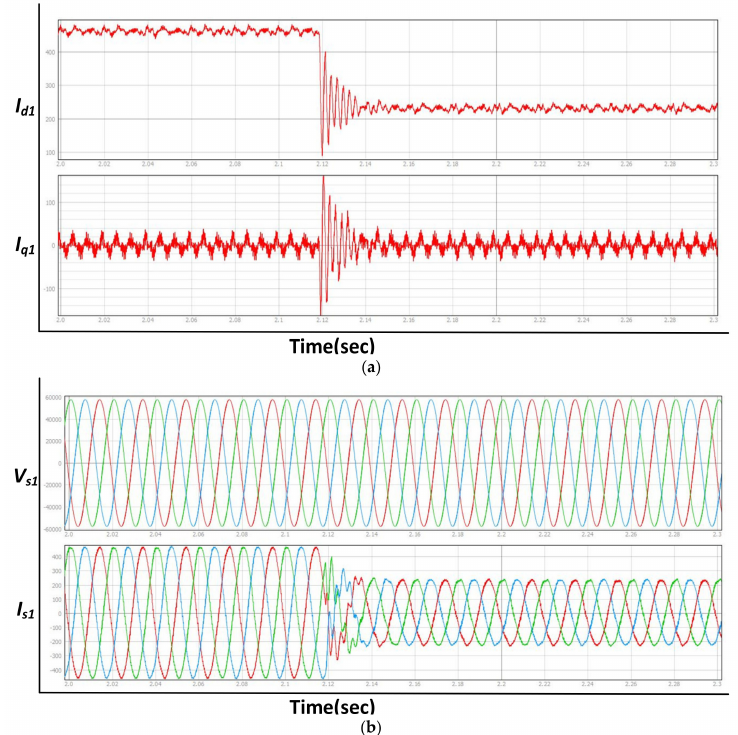
Figure 18. ( a ): Experimental results for the nominal case for I d1 , I q1 of Station 1 for a 50% step change in active power; ( b ): experimental results for the nominal case for V s1 (three phase votlages) and I s1 (three line currents) of Converter Station 1 for a 50% step change in active